Question: Does the plotted quantity increase or decrease?
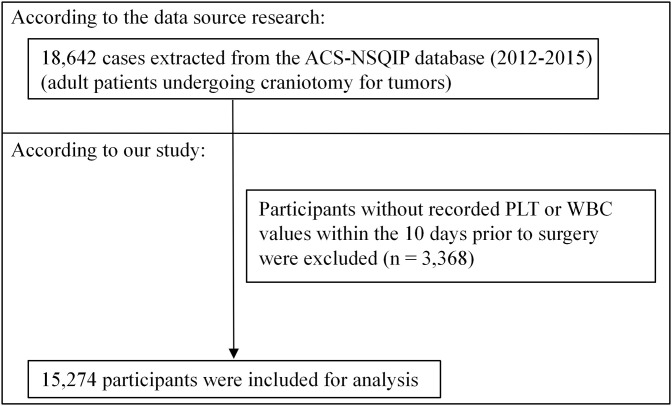
Answer: increasing